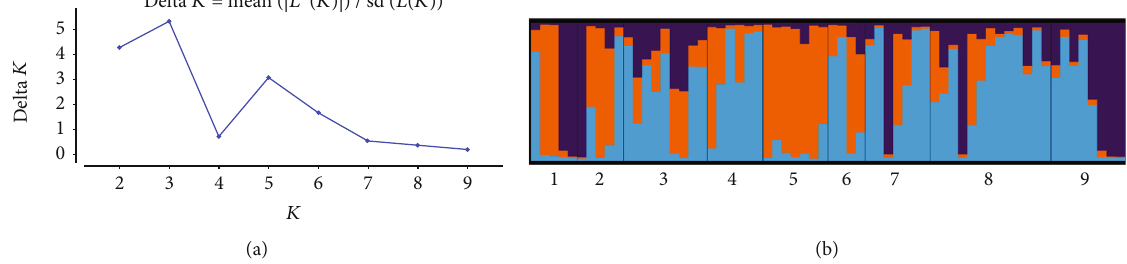
Figure 3: Inferred population structure of 64 tef accessions (a) delta K value. (b) Structure bar plot showing the estimated proportion of membership in three clusters as calculated by structure